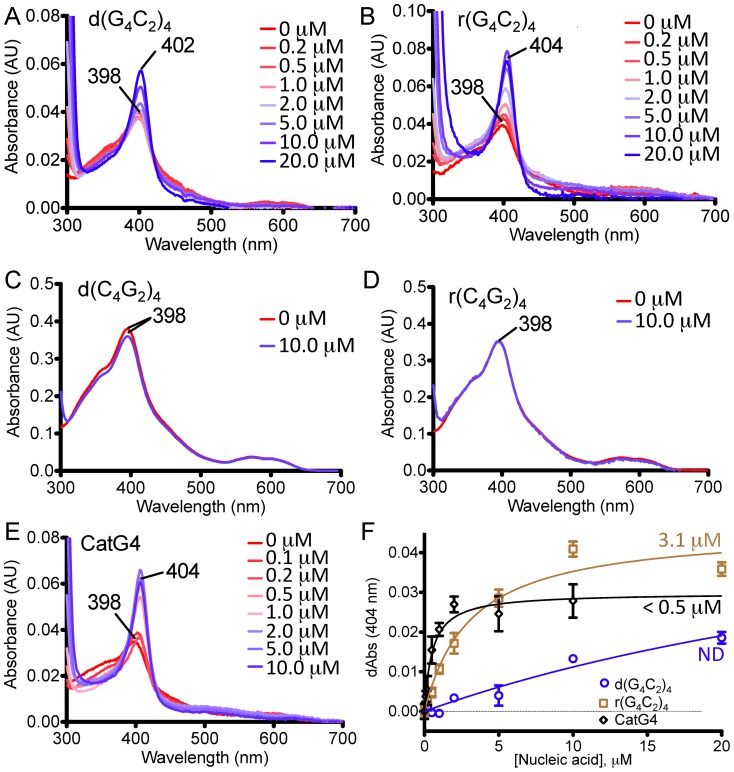
G-repeat expansion RNA and DNA bind heme.UV-visible spectroscopy of fixed concentrations of heme (0.5 µM) titrated and equilibrated with progressively increasing concentrations of DNA/RNA. (A) d(G4C2)4, (B) r(G4C2)4, (C) d(C4G2)4, (D) r(C4G2)4, (E) CatG4. Panel F shows plots of A404nm from each of the plots shown in (A)–(E), as functions of the DNA/RNA concentration.